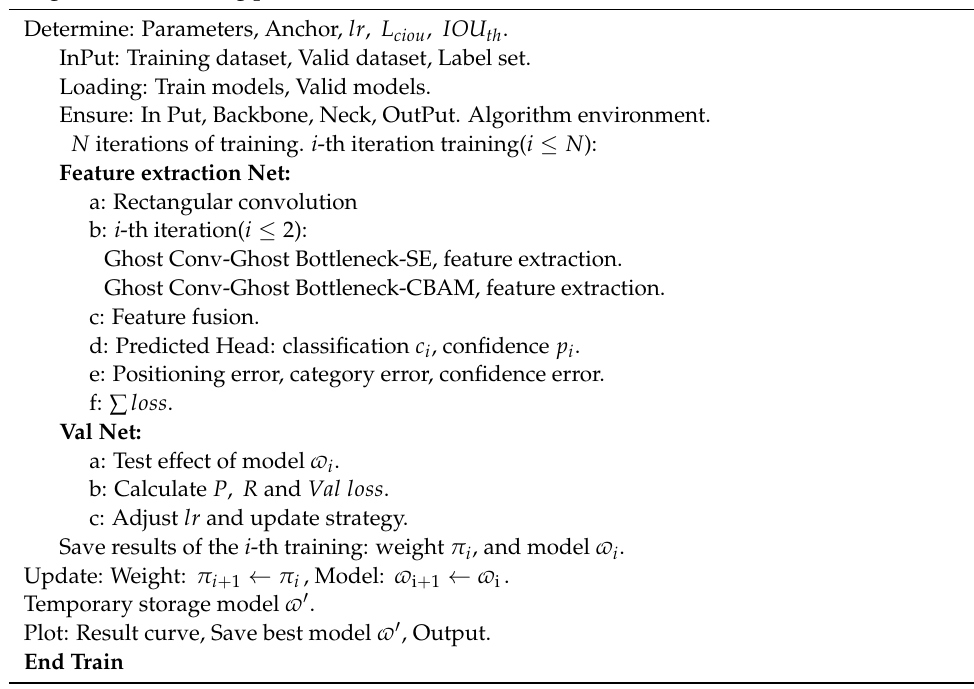
Algorithm 1: Training process of GGSC